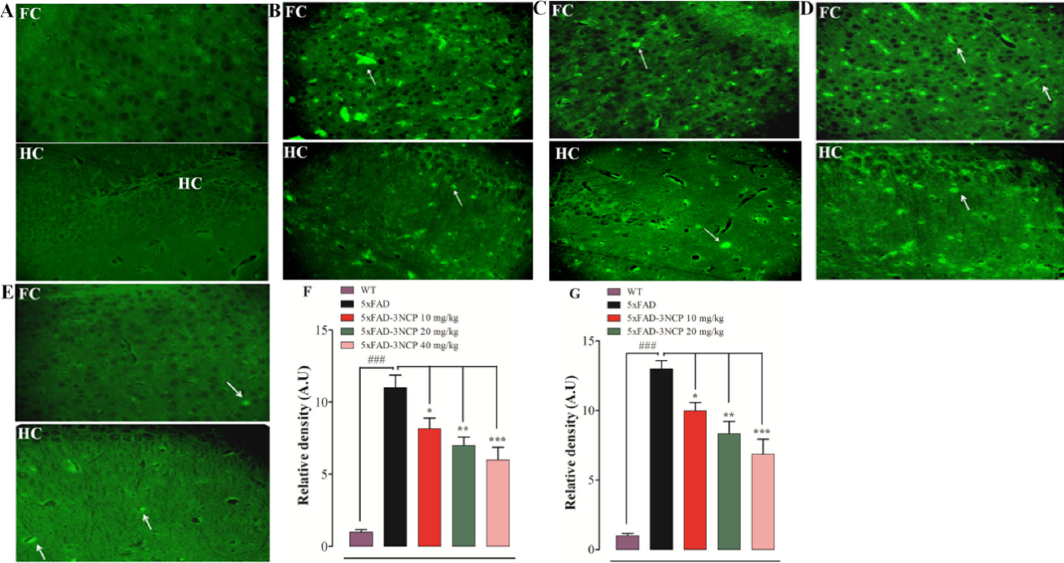
Figure 6. The protective effects of 3NCP on A β plaques in the HC and FC of the 5xFAD mice model. FC and HC regions of the wild type of non ‐ transgenic mice treated with vehicle ( A ), FC and HC regions of the transgenic 5xFAD mice treated with vehicle ( B ), FC and HC regions of the 3NCP (10, 20, 40 mg/kg) treated 5xFAD mice ( C – E ), and the relative density of A β plaques in FC ( F ) and HC ( G ). The data were analyzed through one ‐ way ANOVA followed by the Dunnett post hoc test. * p < 0.05, ** p < 0.01, *** p < 0.01 compared to the 5xFAD ‐ mice, ### p < 0.001 as compared to WT ‐ mice.